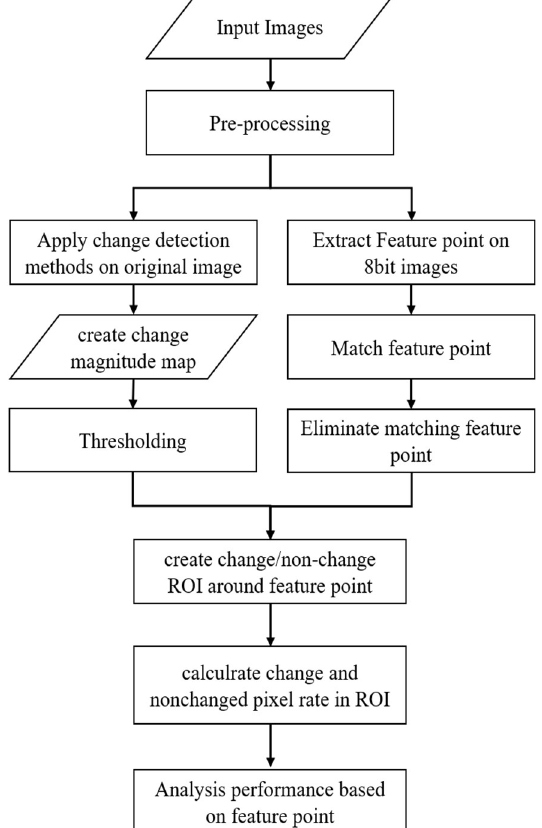
Figure 2. Our feature-based change detection